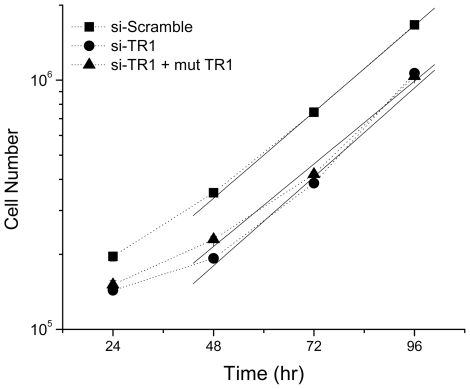
Cell growth kinetics of RKO cells with modulated TR1 levels.A scrambled siRNA was used as a control to measure the basal growth rate (filled square) TR1 was knocked-down by siRNA (filled circle) and with induction of the Sec-deficient, C-terminal mutant TR1 (filled triangle). No significant differences in growth rates were observed as the solid lines used to calculate the growth rates for these conditions are nearly parallel.